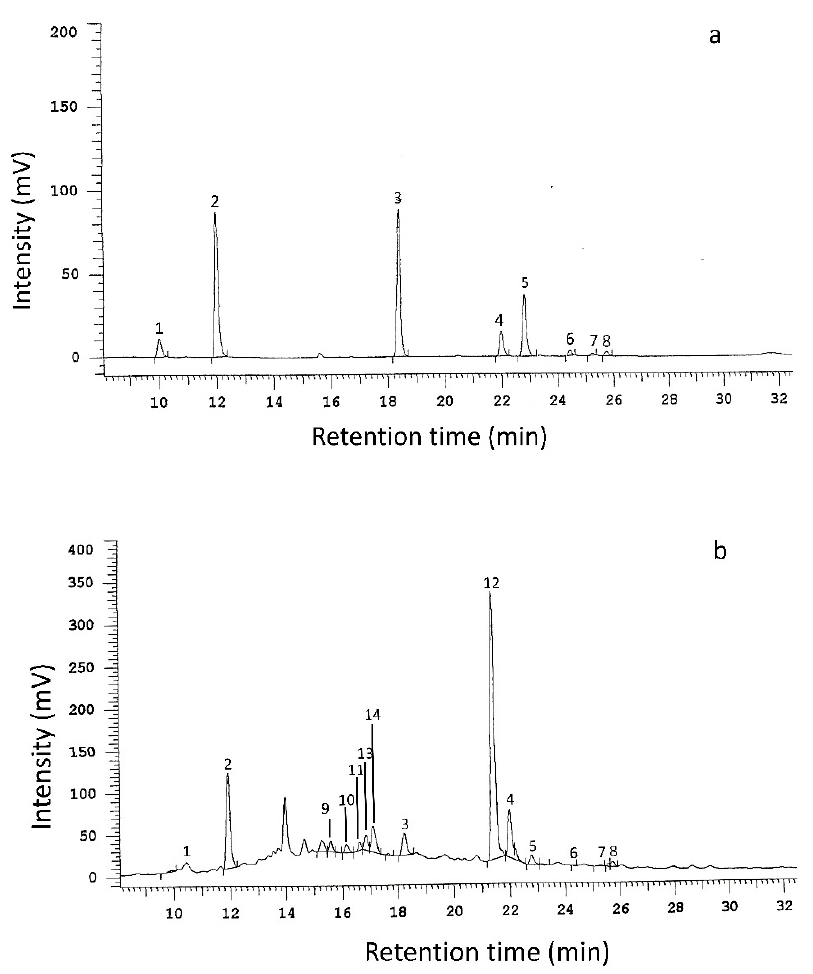
Figure 2. HPLC chromatograms of standards ( a ) and of a Pinus (in this case P. halepensis ) extract ( b ) recorded at 280 nm: 1—gallic acid; 2–5—hydroxymethylfurfural; 3—( − )-epicatechin; 4—taxifolin; 5—ferulic acid; 6—rutin; 7—resveratrol; 8—solariciresinol; 9—protocatechuic acid hexoside; 10—gallic acid hexoside; 11—ferulic acid glucoside; 12—quercetin hexoside; 13—unk #A; 14—unk #B.